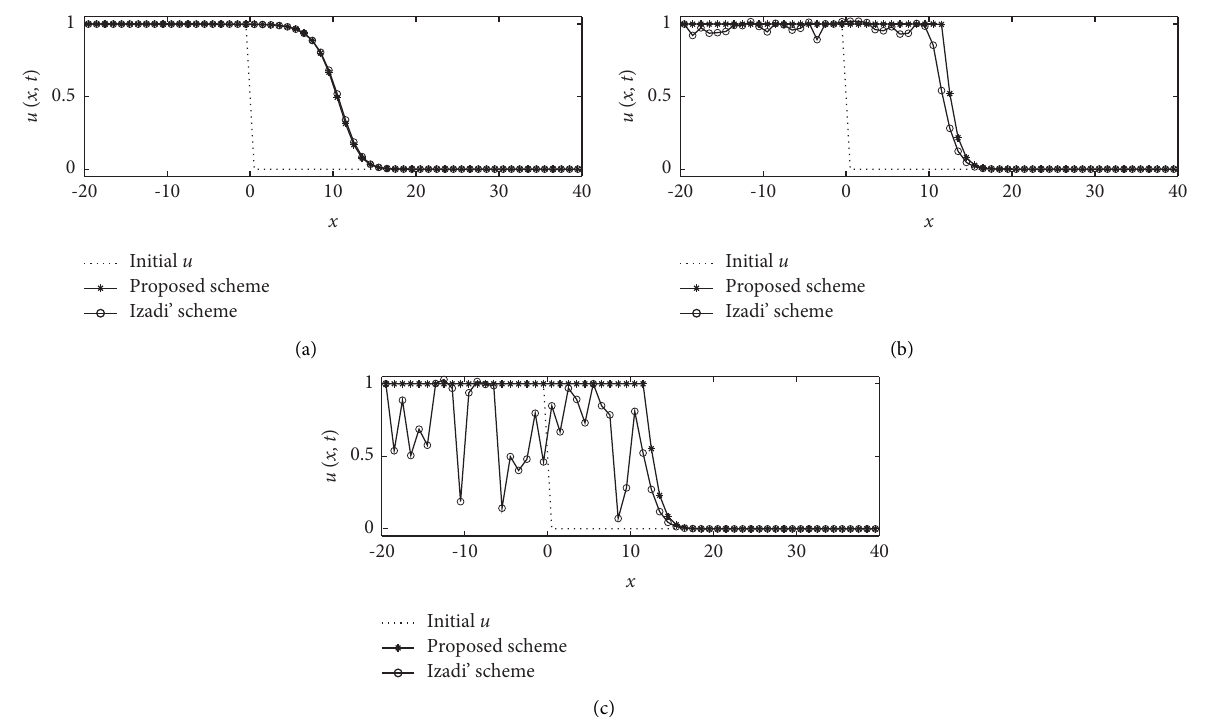
Figure 14: Numerical solution comparison of the proposed method and recently developed method [10] for various values of p � 1 , 80, and 800. (a–c) Numerical solutions with p � 1 , 80, and 800, respectively.